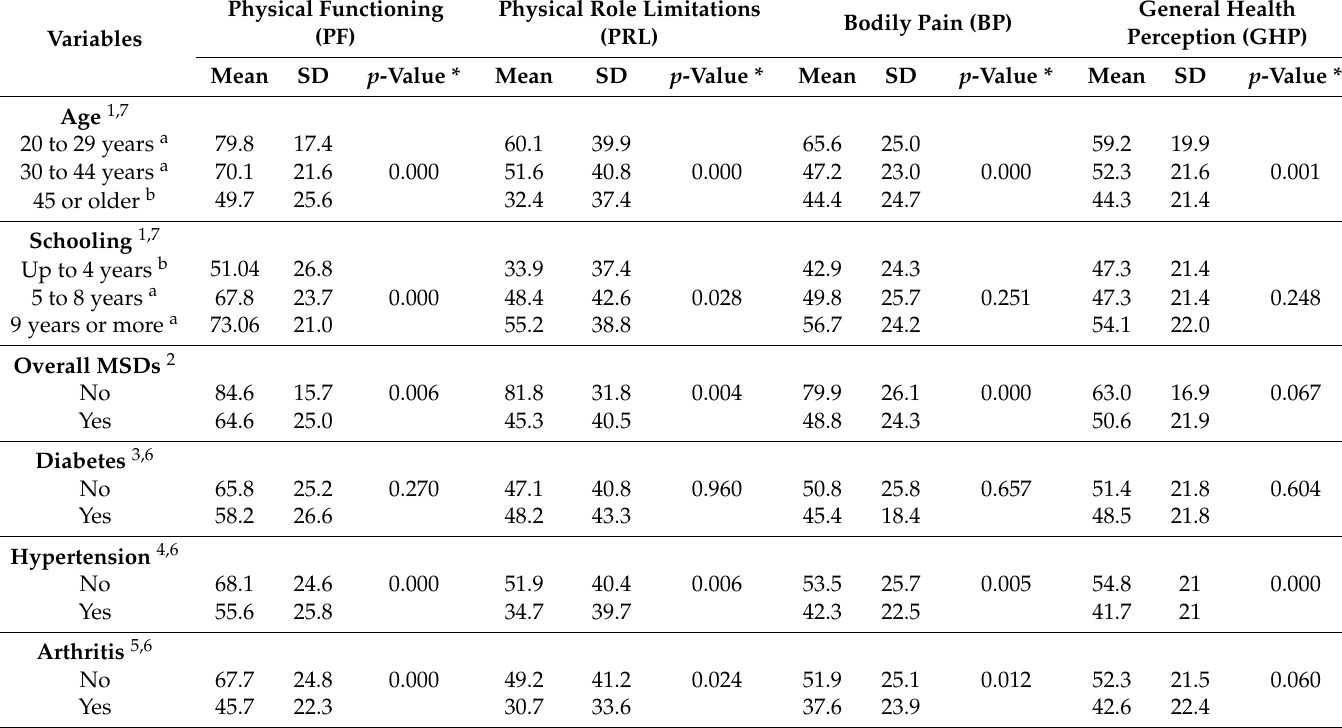
Table 4. Mean and standard deviation of the SF-36v01 instrument scores for sociodemographic categorical variables and chronic diseases with p -value of parametric and non-parametric tests of artisanal fisherwomen/shellfish gatherers in the city of Saubara, Bahia, Brazil,